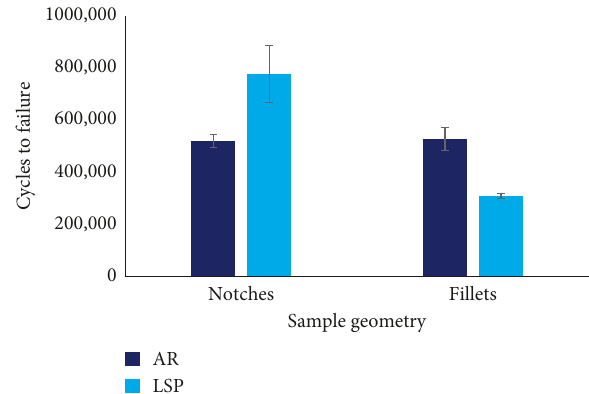
Figure 10: Fatigue life for different sample geometry in function of samples geometry for treated and untreated samples.